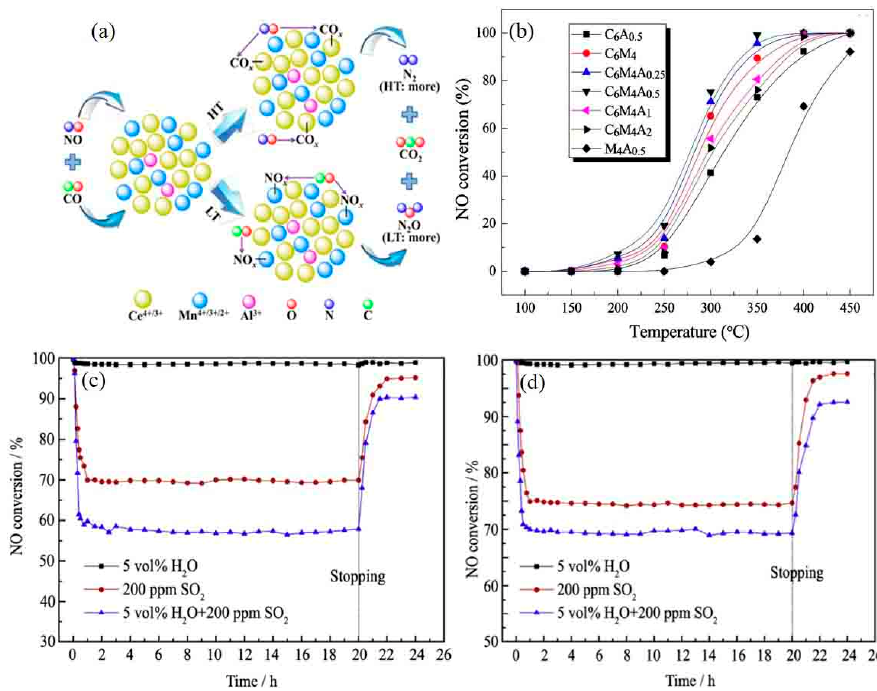
Figure 12. ( a ) The mechanism of selective catalytic CO removal from CeO 2 -MnO x -Al 2 O 3 surface, ( b ) NO conversion of Ce-Mn/Al 2 O 3 catalyst [200] (Reproduced from Ref. [200], Copyright 2016, Elsevier.), and ( c , d ) Mn-Mo-WO x / TiO 2 -SiO 2 catalyst CO-SCR for sulfur and water resistance [201]. (Reproduced from Ref. [201], Copyright 2018, Elsevier.) Table 5. Effects of different synthetic methods on de-NO x activity of CO-SCR.